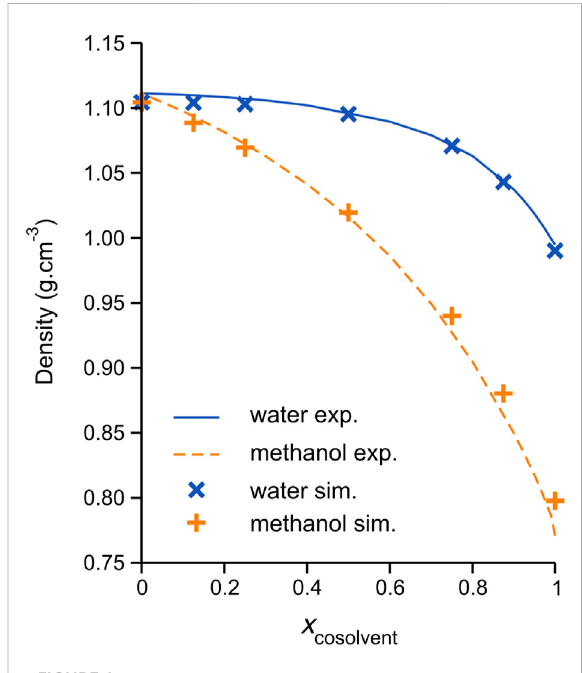
FIGURE 1 Average densities of simulated ChCl/ethylene glycol (1: 2 molar ratio) DES and pseudo-binary mixtures with either water (blue crosses) or methanol (orange plus signs) cosolvent at 308.15 K. Thesolidblueanddashedorangelinesconnect the recently reported experimental data of Wang et al. (Wang Y. et al., 2020) for the water and methanol mixtures, respectively. The density data is plotted as a function of mixture composition, expressed as a mole fraction